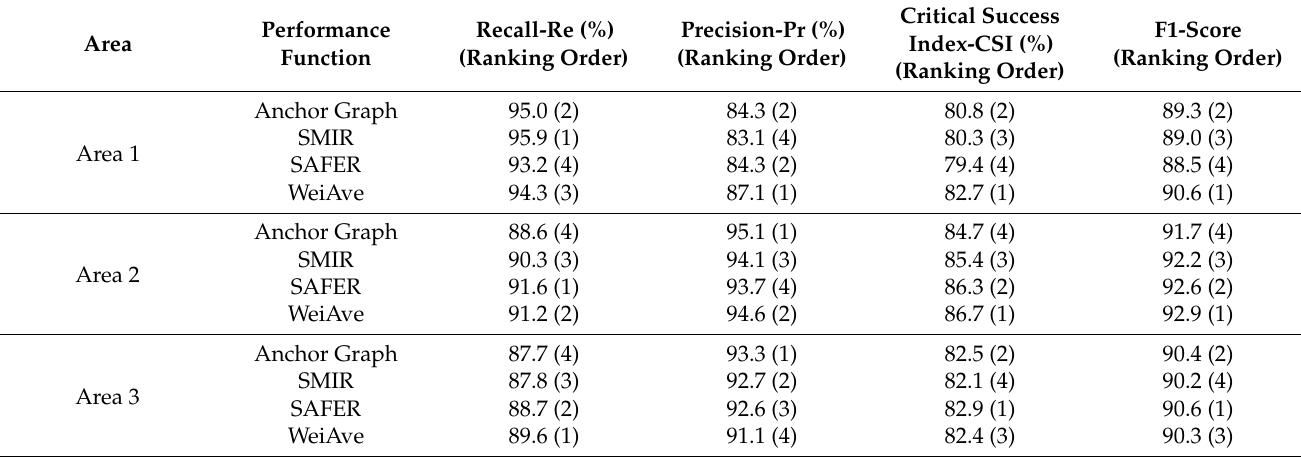
Table 7. Performance evaluation of the two-class classification for different objective criteria. The results are the average for the two categories.